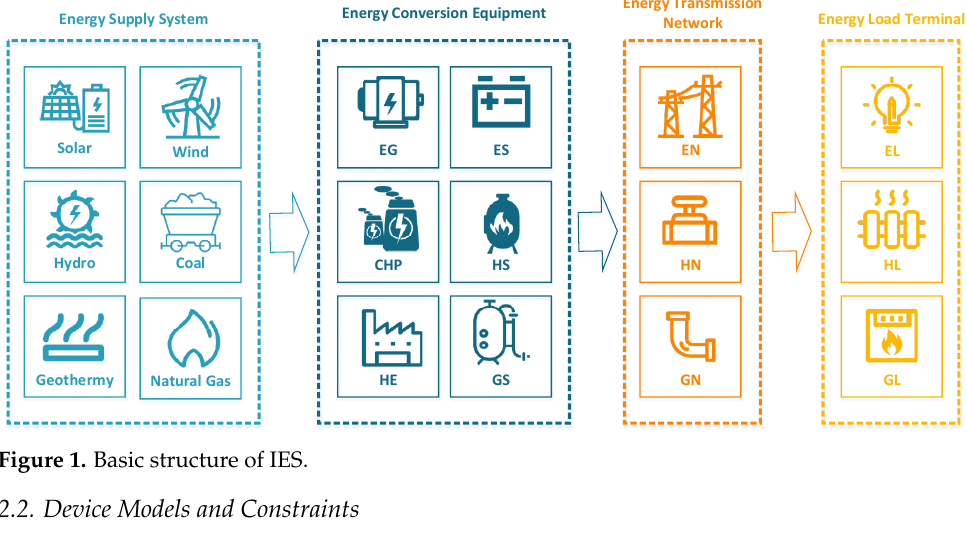
Figure 1. Basic structure of